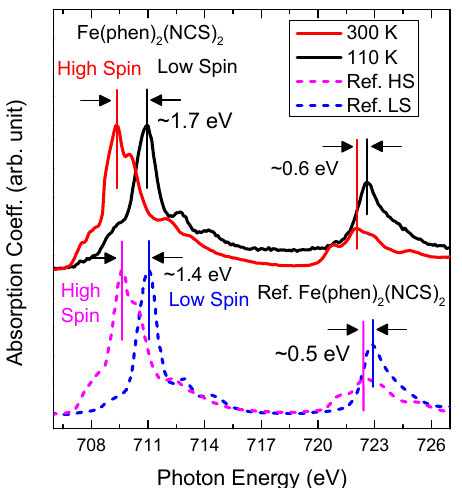
Figure 4. Fe L 2,3 -edge XAS spectra of Fe(phen) 2 (NCS) 2 complex recorded at 300 K (above T C ) and 110 K (below T C ), with reference spectra from the same composition [34], clearly showing a LS-HS SCO without any SOXIESST effect.